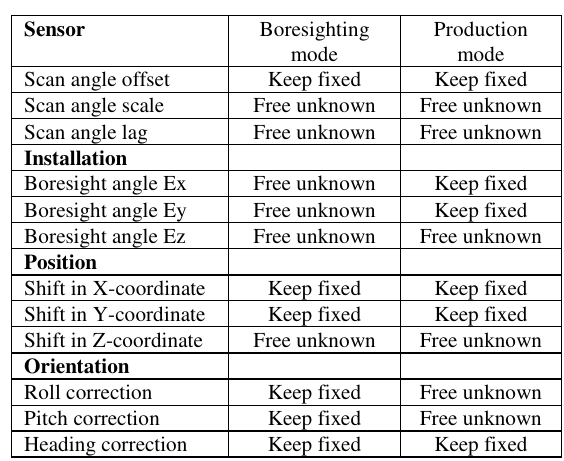
Table 1. Typical settings for sensor and installation parameters adjustment If a cross strip was flown, the shift in Z coordinate should be fixed for that line only. If prior knowledge of the tolerance is available, parameters can be set to be constraint values. The “boresight” setup solves for a single roll, pitch, heading, scale and lag factor for the entire mission and performs a vertical correction to each flight line.